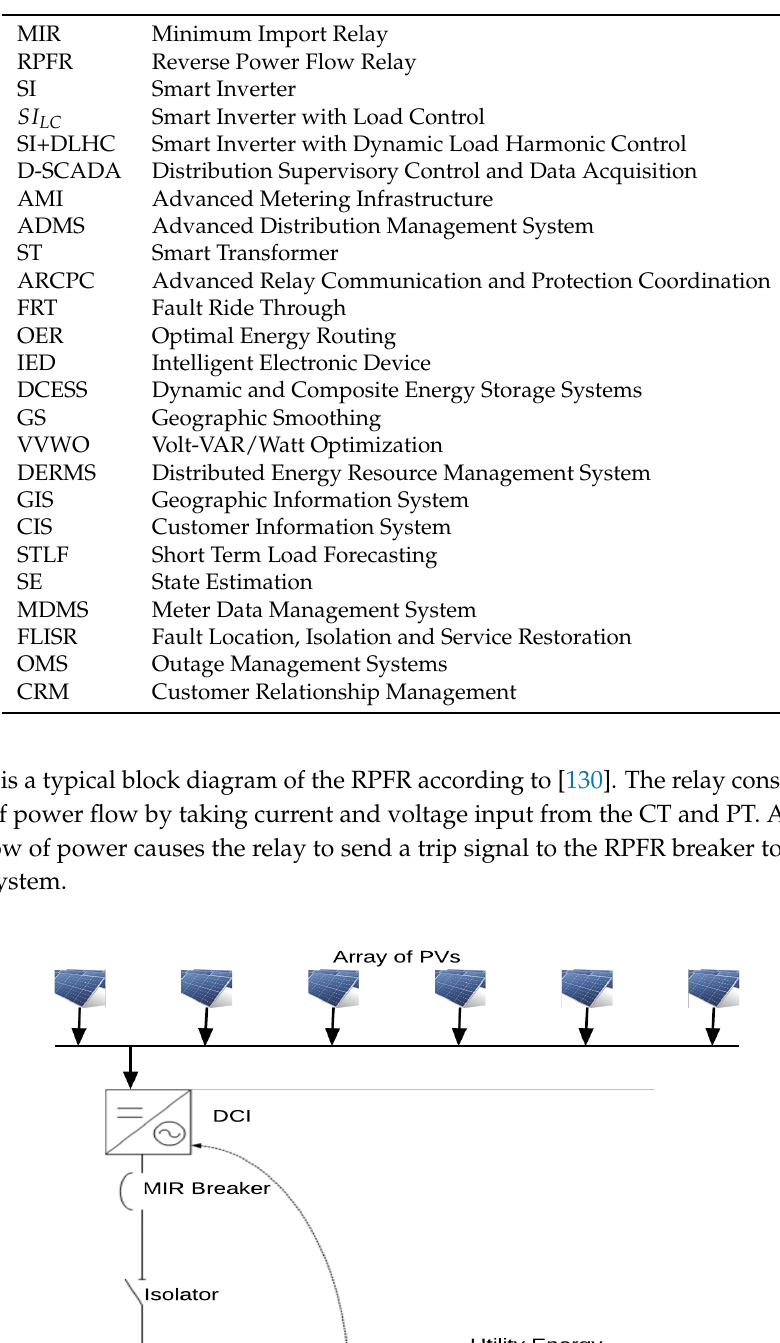
Table 1. Acronyms for Solutions.